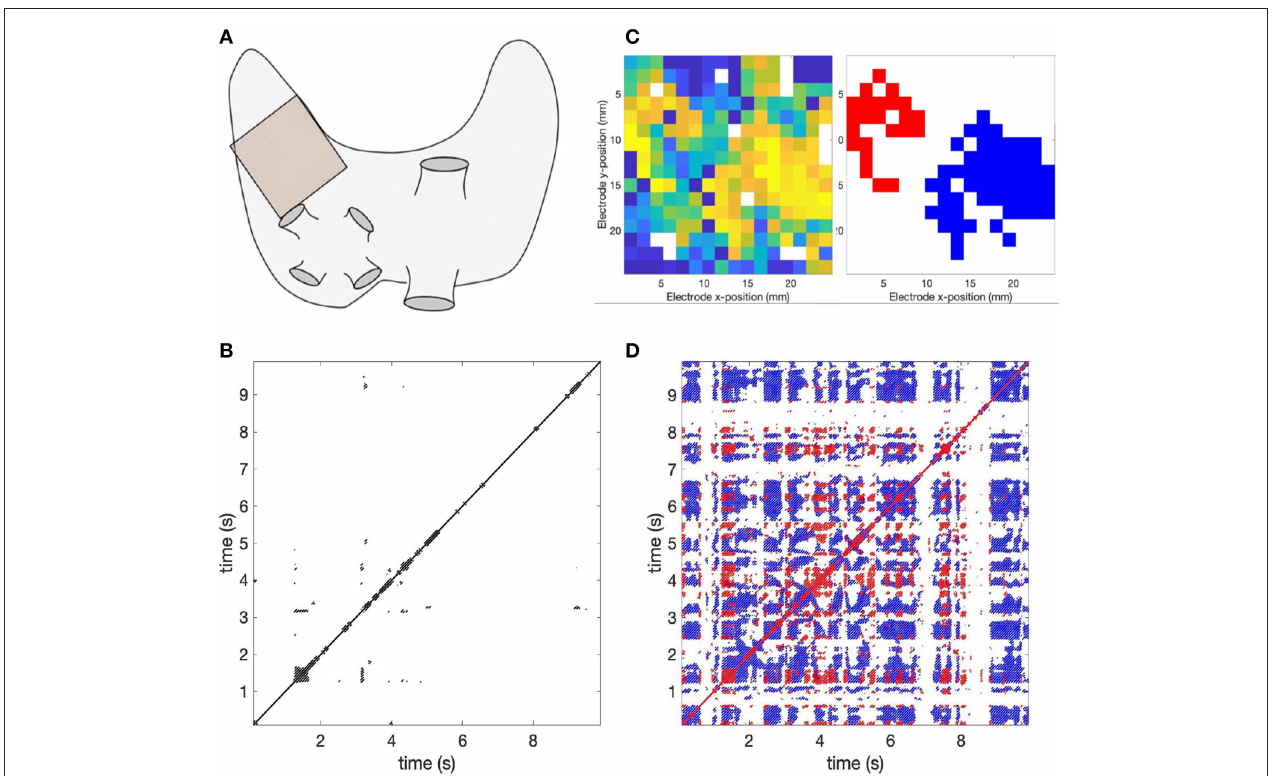
FIGURE 13 | Application of the spatio-temporal recurrence detection framework to high-density contact mapping recordings in an ovine model of AF. (A) a high-density grid of electrodes was used to record conduction patterns during AF in a healthy adult sheep, on the left atrial free wall during an open-thorax procedure. (B) a recurrence plot of a 10 s recording based on activation-phase similarity. Overall recurrence is limited and short-lasting (recurrence rate: 0.23% determinism: 88.17%, minimal diagonal line length 1 AF cycle). (C) application of the spatio-temporal recurrence detection framework produced a heat map of electrode-cluster incidence (left) and corresponding candidate recurrence regions (right). (D) Recurrence plots of the selected regions with corresponding colors (blue and red), with increased recurrence [recurrence rates: 5.31% (blue) and 1.55% (red), determinism: 83.79% (blue), and 56.18%